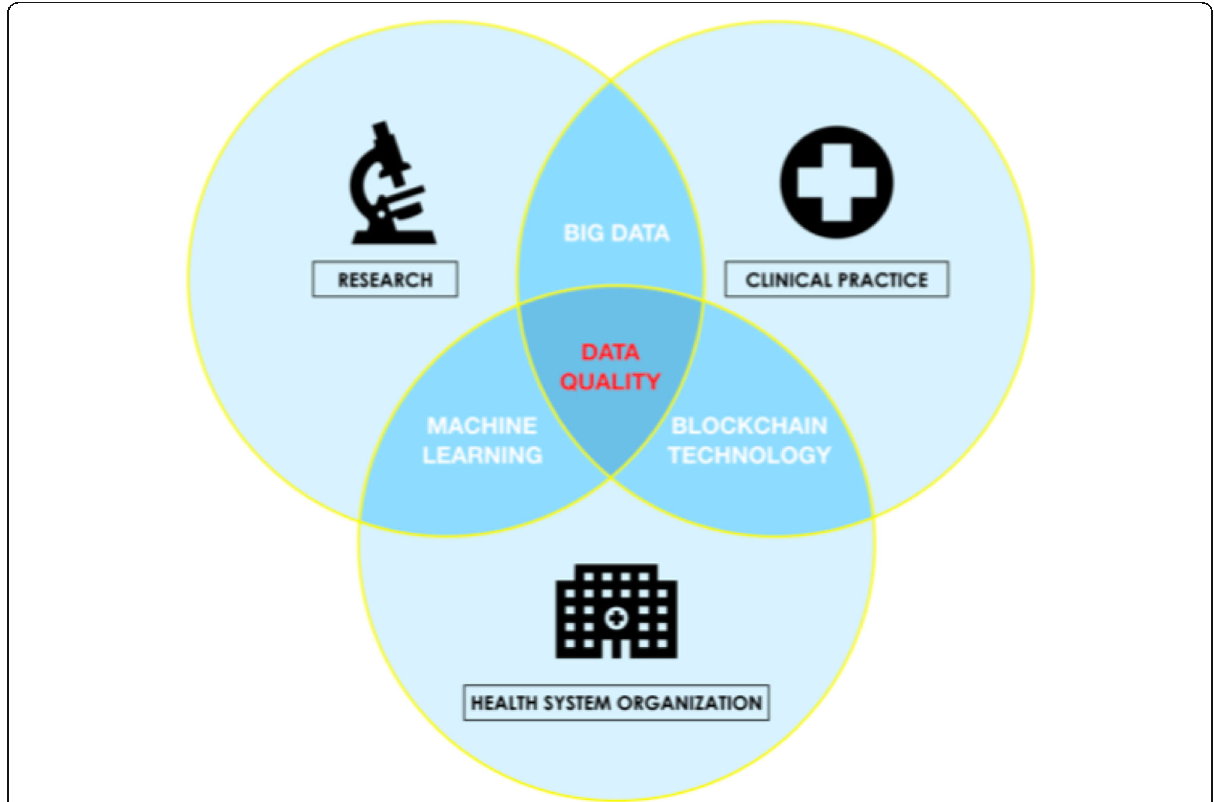
Fig. 6 Importance of acquisition of data quality for application of AI in different fields such as research, clinical practice, and health system